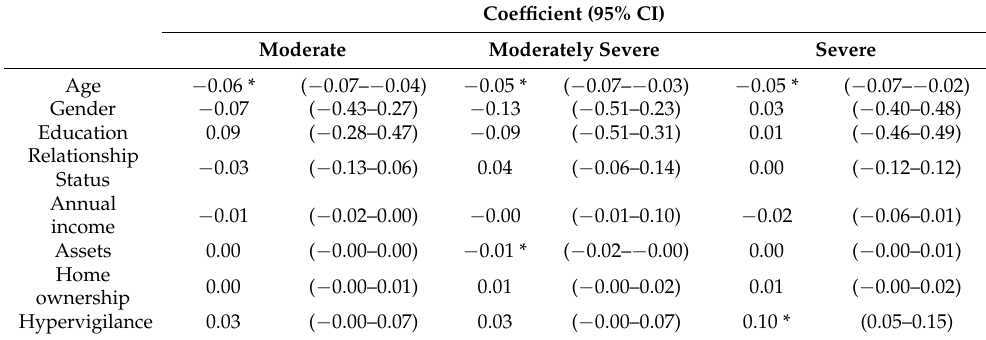
Table 3. Association between Hypervigilance and Severity of Depressive